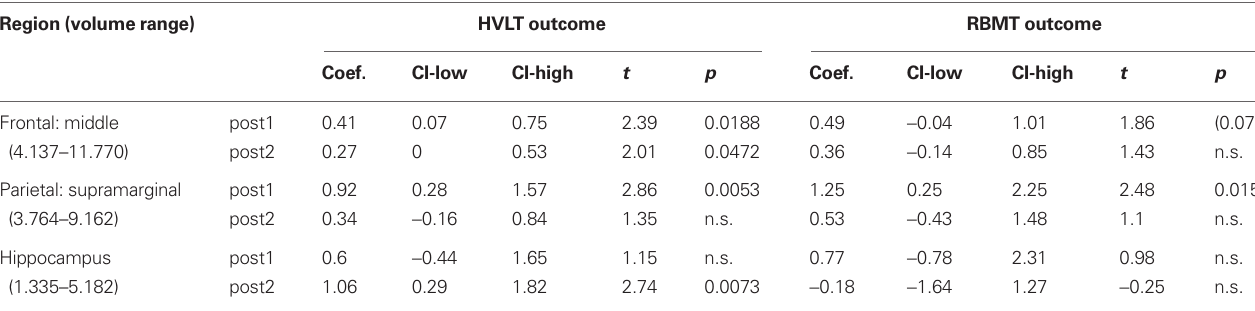
Table 5 | Positive prediction regression results for the regional gray matter volume term in a priori regions of interest for all outcomes. region (volume range) HvLT outcome rBMT outcome Coef. CI-low CI-high t p Coef.